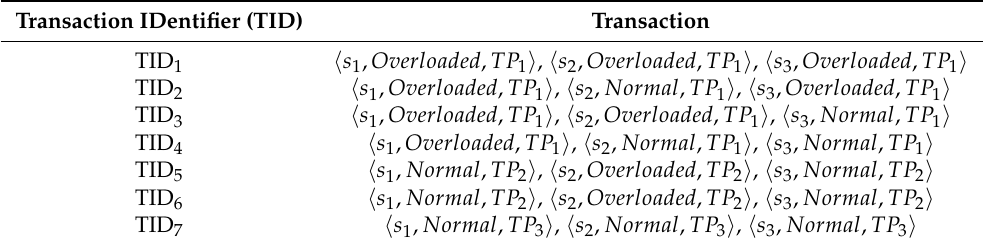
Table 2. Example of Occupancy level dataset in transactional